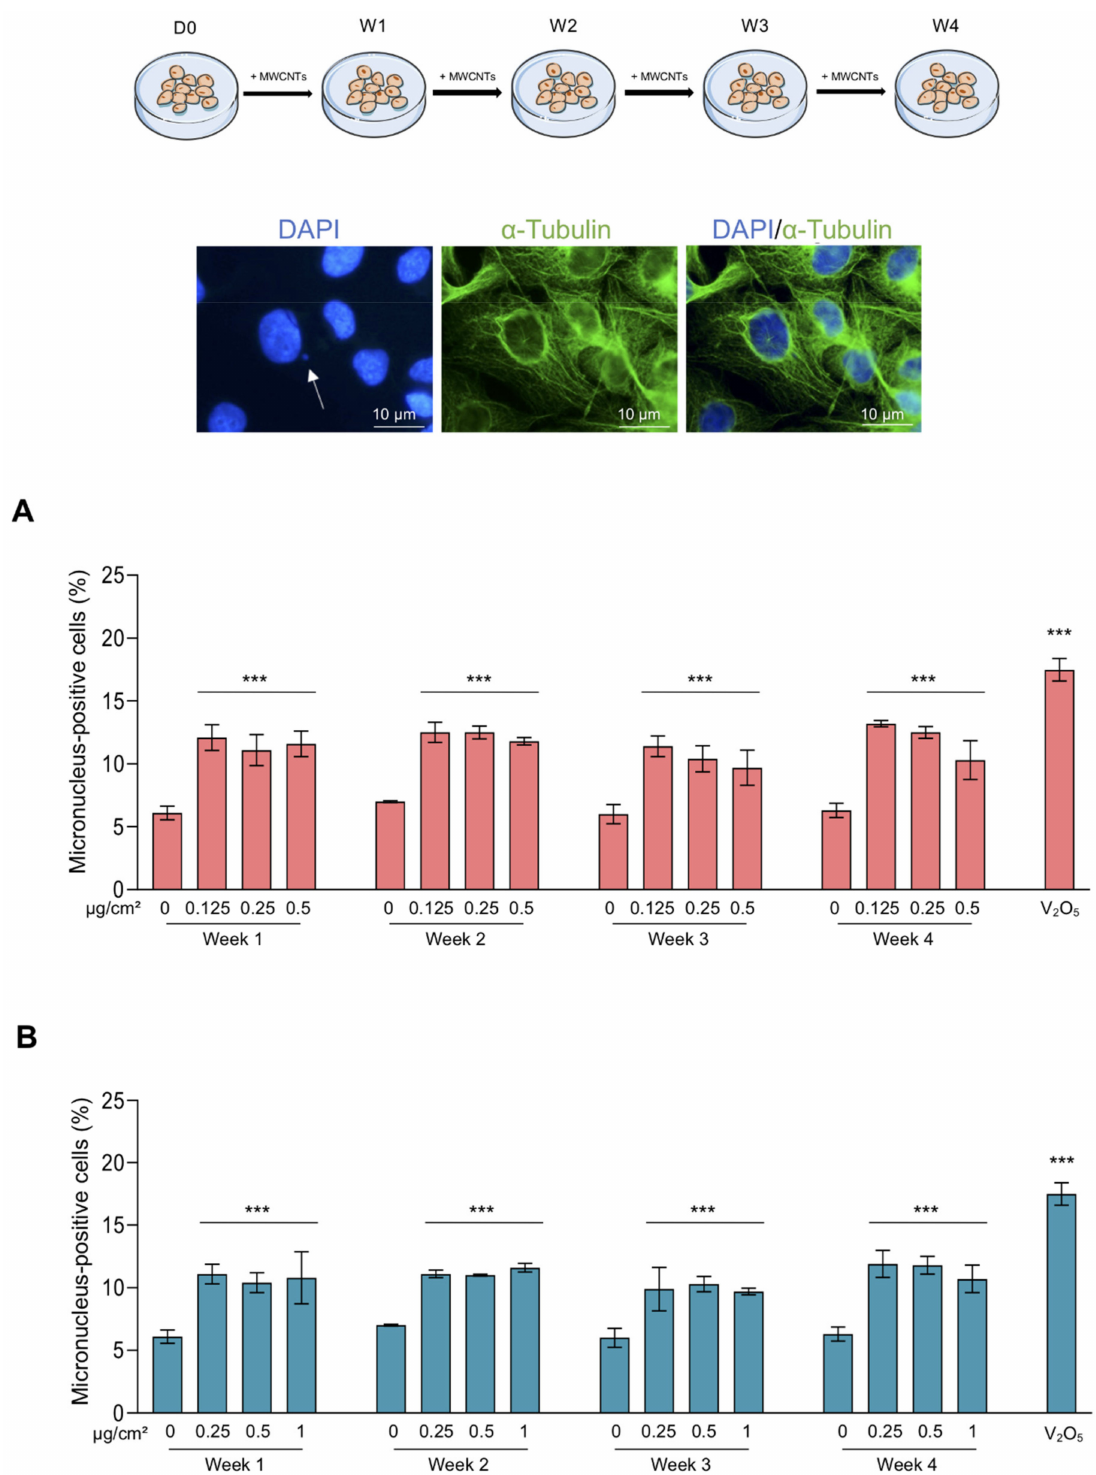
Figure 4. Treatment with Mitsui-7 and NM-403 increased the occurrence of micronuclei. The cells were treated with ( A ) Mitsui-7 (0.125, 0.25 and 0.5 µ g/cm 2 ) or ( B ) NM-403 (0.25, 0.5 and 1 µ g/cm 2 ) for 4 weeks. The cells were immunolabeled with an anti- α -Tubulin antibody and the nuclei were stained with DAPI and 2000 cells were analysed in each sample. The fluorescent microscopy images represent a micronucleus following DAPI staining (white arrow). The histograms indicate the percentage of micronucleus-positive cells. A treatment with vanadium oxide (V 2 O 5 , 1.25 µ g/cm 2 ) for 24 h was used as a positive control. The histograms represent the mean ± standard error of the mean (SEM) of three independent experiments. *** p < 0.001 significantly different from the